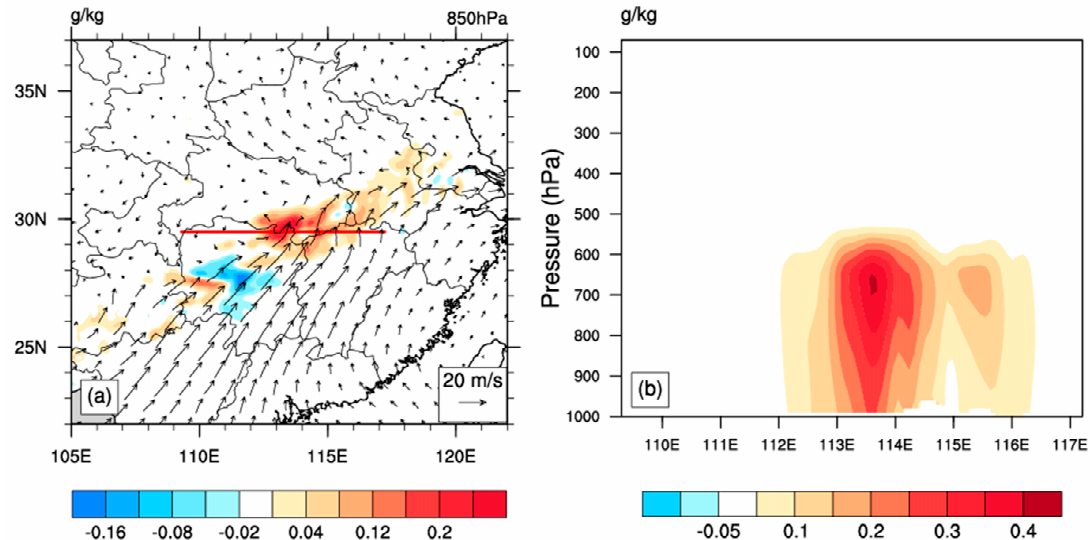
Figure 14. ( a ) The POD analysis increment of rainwater mixing ratio (shaded, g / kg) and analysis of horizontal wind (vectors) at 850 hPa at 0000 UTC 30 June. ( b ) The east-west cross-section of rainwater mixing ratio (shaded, g / kg) increments along the red line in ( a ).